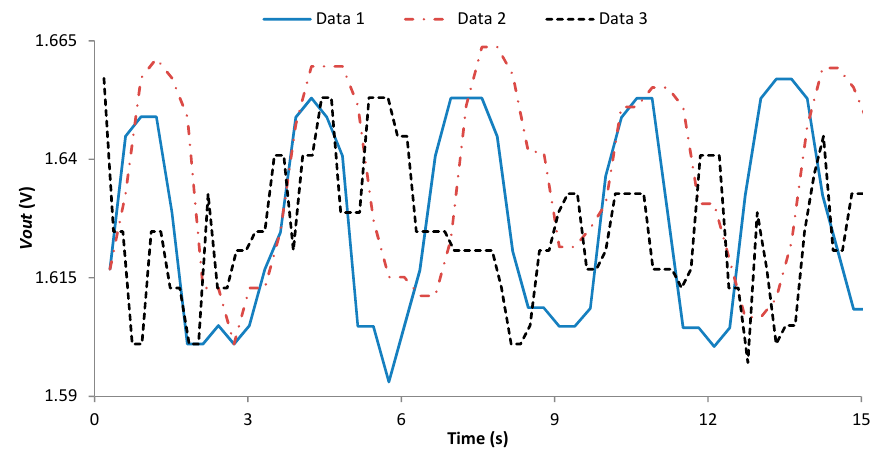
Figure 22. Data gathered by the fish presence sensor.